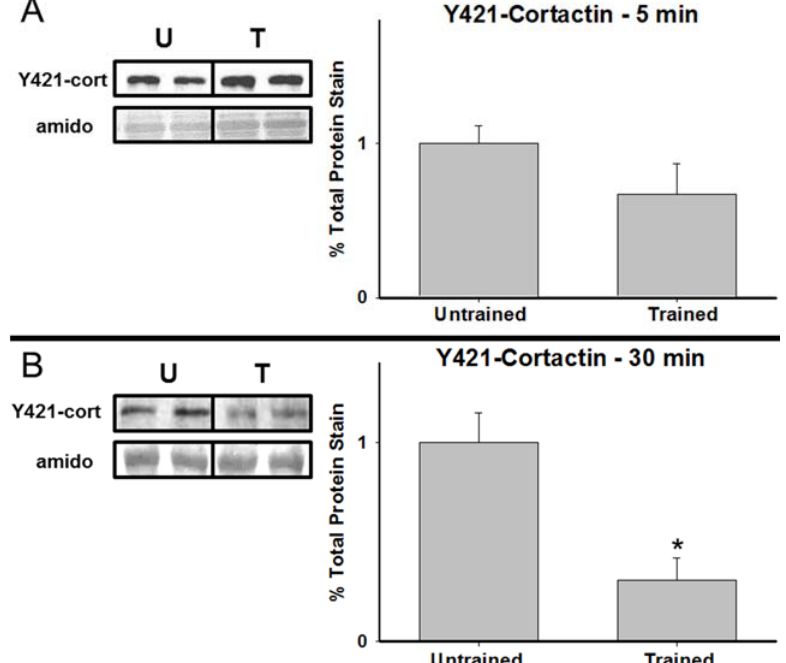
Figure 2. Cortactin is transiently reduced 30 min after RAM training. Representative immunoblots and group means for hippocampal cortactin (±SEM; expressed as percent of untrained controls) at 5 min, 30 min, and 4 h following RAM training. * p < 0.05 compared to untrained